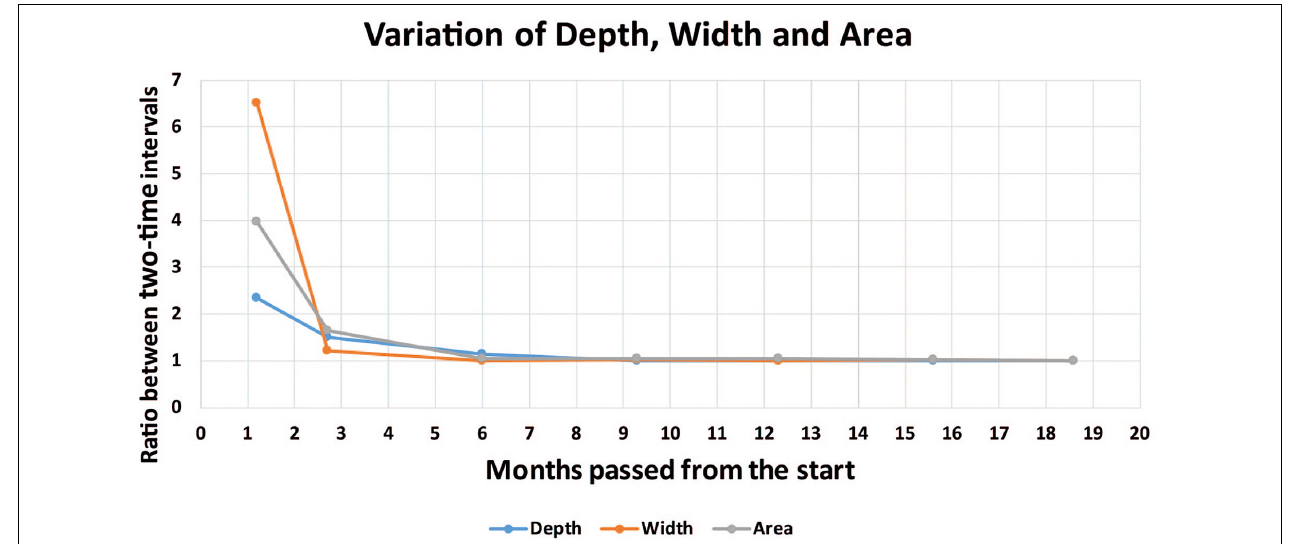
FIGURE 10 | Variation of depth, width and cross-section of the inlet expressed as the ratio between two-time intervals from June 2015 to January